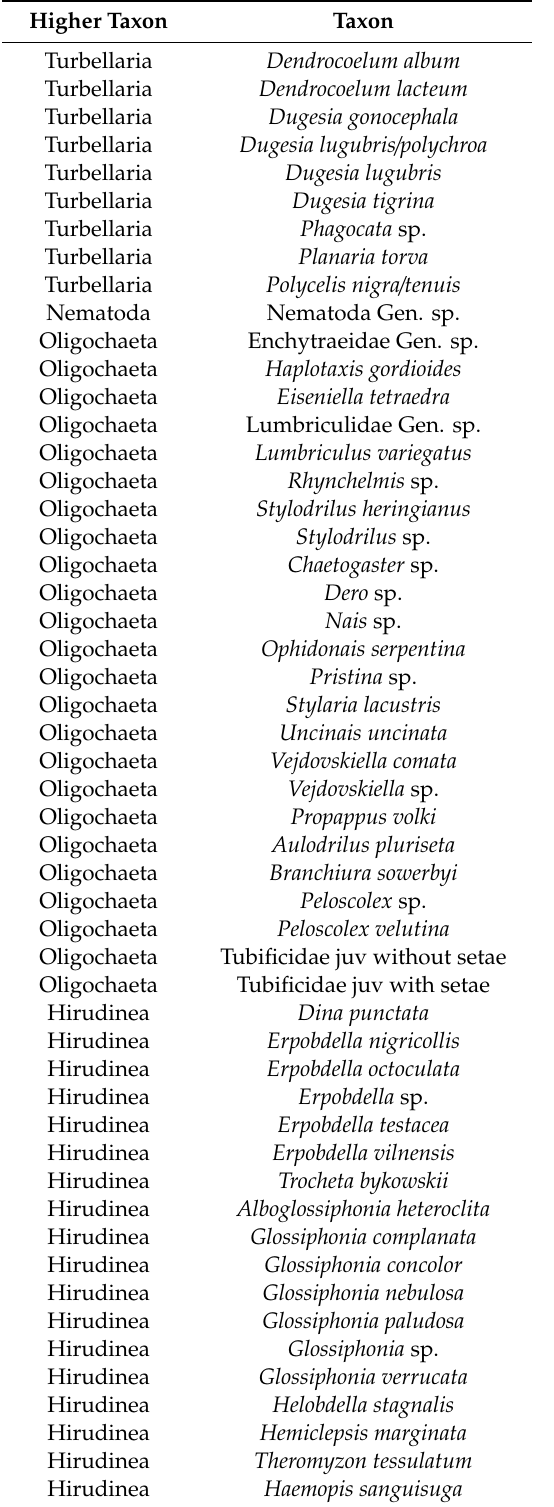
Table A2. List of the 292 benthic invertebrate taxa recorded at 104 river sampling sites. Ad.-adults, Lv.-larvae,